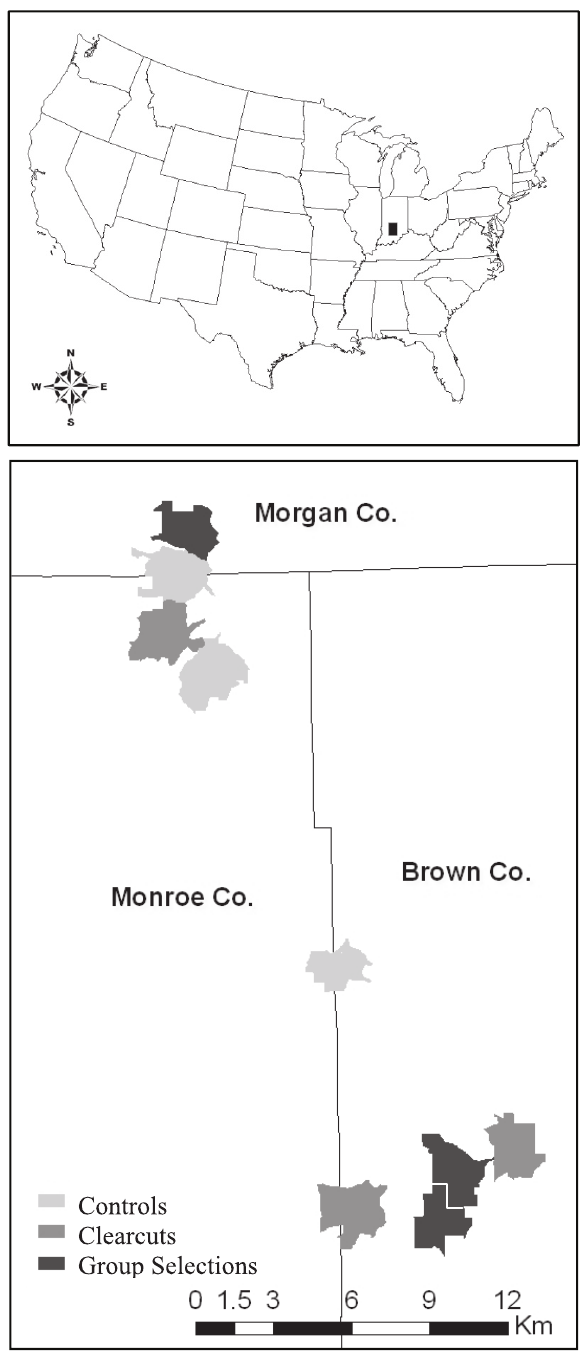
Figure 1. Study Area Maps. Regional and local map of the study area in south-central Indiana. a) The location of the study area in Indiana relative to the continental US. b) The nine study sites spanning Morgan, Monroe, and Brown Counties in IN. Polygon colors represent management classes (controls=light grey, clearcuts=medium grey, group selections=dark